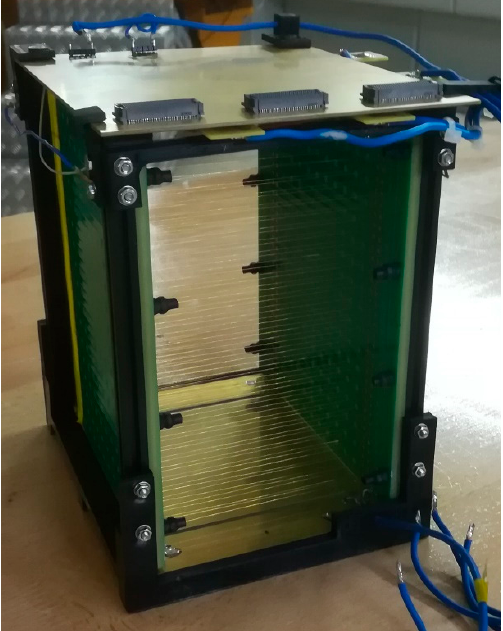
Figure 9. One of the eight modules of the gas tracker, which has been used as prototype for testing purposes.